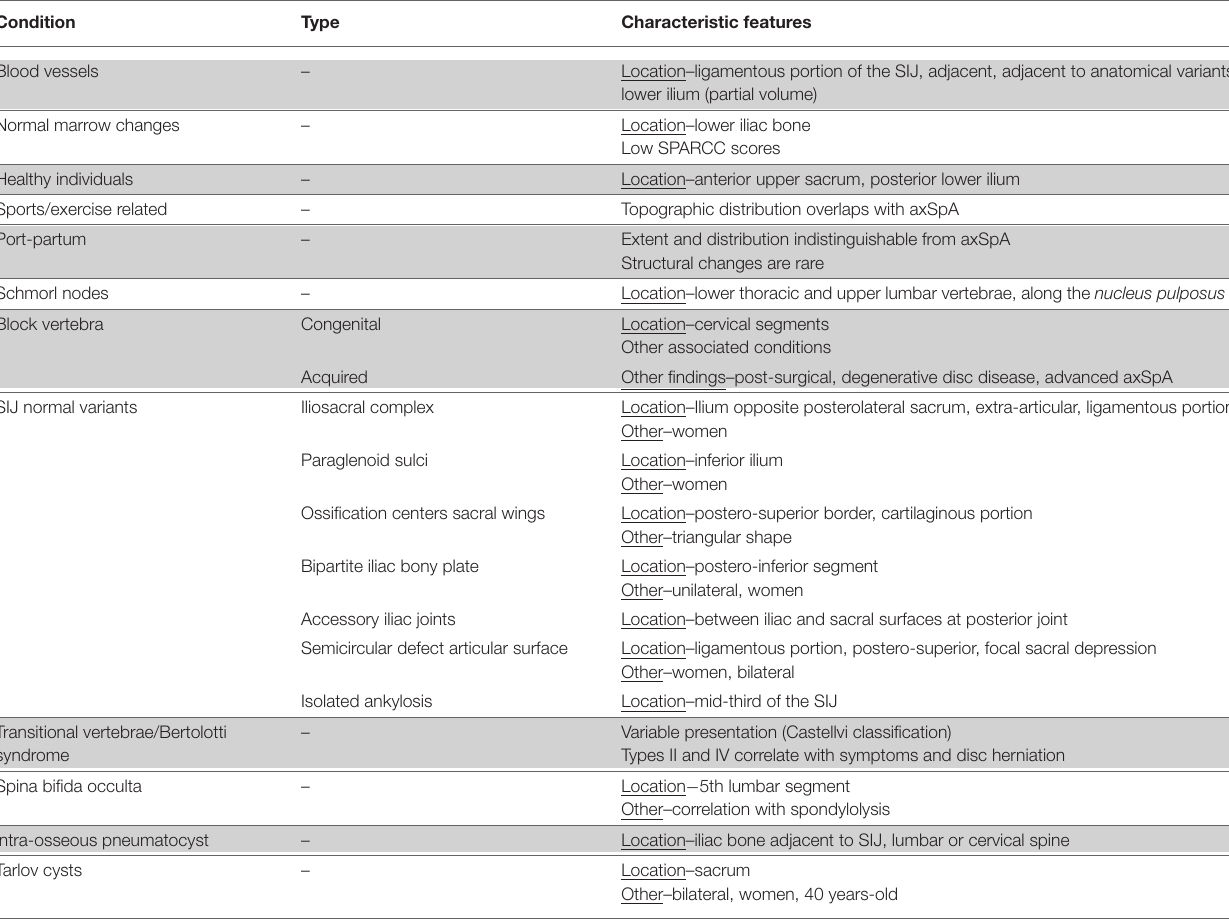
TABLE 2 | Congenital disorders and normal variants of the sacroiliac joints and spine that mimic axial